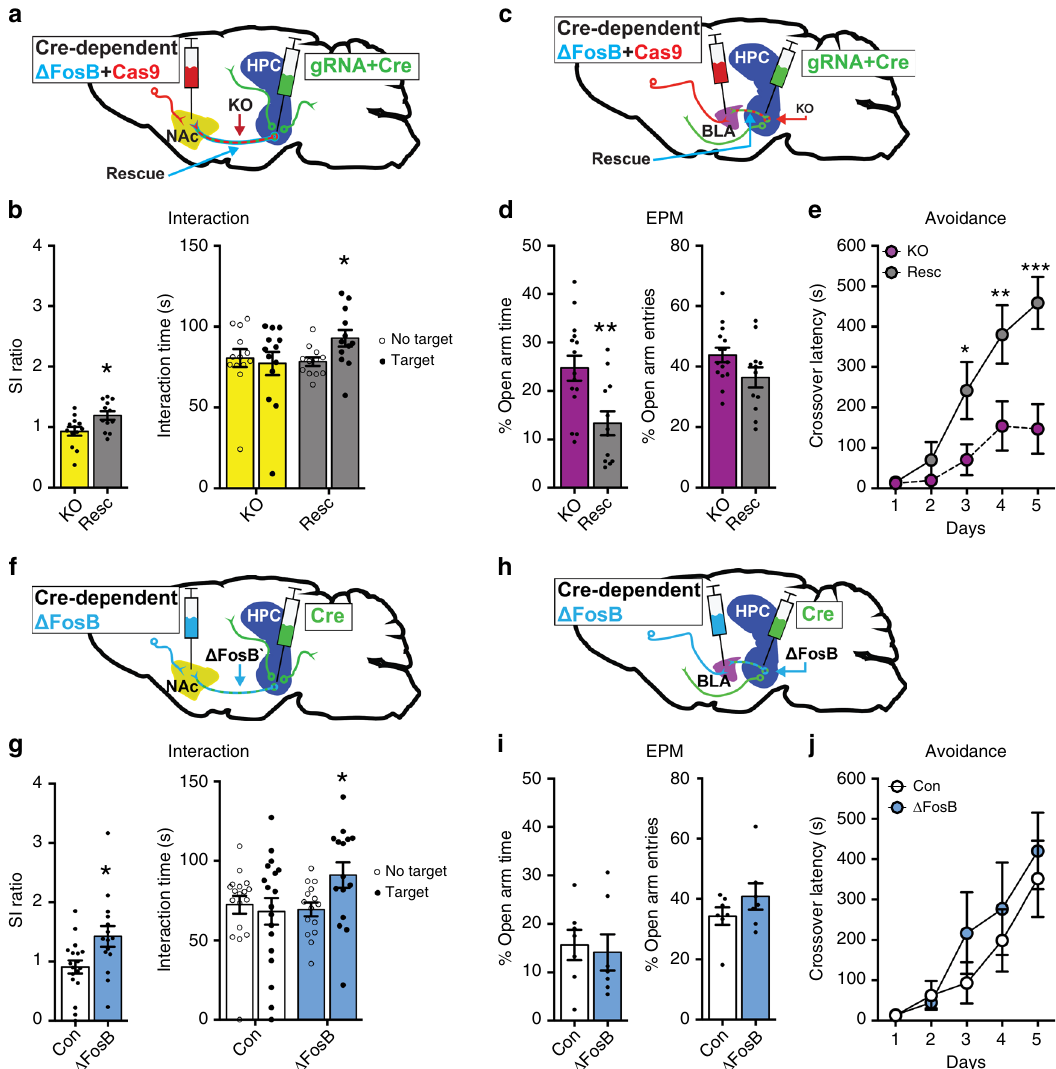
Fig. 3 Circuit-speci fi c vHPC Δ FosB mediates stress resilience and anxiety-like behavior. a Schematic of Δ FosB rescue experiments in vHPC-NAc afferent neurons. Retrograde vector expressing Cre-dependent Cas9 and Δ FosB is injected into NAc while local vector expressing Cre and FosB guide gRNA is injected into vHPC. FosB silencing (KO) occurs in co-transduced vHPC-NAc neurons, and Δ FosB overexpression is also driven by Cre in the same neurons (Rescue). b Δ FosB rescue (Resc) in vHPC-NAc neurons reverses stress-induced social avoidance, indicated by enhanced social interaction ratio (left) and increased investigation of a social target (right). * P = 0.0161 for SI ratio and * P = 0.0431 for interaction time ( n = 13 KO, n = 12 Resc; SI ratio: independent samples t -test compared to KO; investigation time: two-way mixed ANOVA with Holm – Sidak post-test KO No Target vs Target). c Schematic of Δ FosB rescue experiments in vHPC-BLA afferent neurons. d Δ FosB rescue in vHPC-BLA neurons reverses the anxiolytic effects of FosB silencing, decreasing open arm time in the EPM. ** P = 0.0042 ( n = 15 KO, n = 12 Resc; independent samples t -test compared to KO). e Δ FosB rescue also reverses avoidance learning impairment. * P = 0.0459, ** P = 0.0060, *** P < 0.0001 ( n = 15 KO, n = 13 Resc; two-way mixed ANOVA with Holm – Sidak post-tests compared to KO). f Schematic of Δ FosB overexpression in vHPC-NAc afferent neurons. Retrograde vector expressing Cre-dependent Δ FosB is injected into NAc while local vector expressing Cre is injected into vHPC. Δ FosB overexpression is driven by Cre only in co-transduced vHPC-NAc neurons ( Δ FosB). g Δ FosB overexpression in vHPC-NAc enhances social interaction following stress, producing a resilient phenotype. * P < 0.05 ( n = 18 control, n = 12 Δ FosB; SI ratio: independent samples t -test compared to control; interaction time: two-way ANOVA followed by Holm – Sidak post-test Δ FosB No Target vs Target). h Schematic of Δ FosB overexpression in vHPC-BLA afferent neurons. i , j Δ FosB overexpression in vHPC-BLA does not alter anxiety-like behavior or avoidance learning ( n = 7 mice/group). All graphs are represented as mean ± overexpress recombinant Δ FosB back into the same circuit in (Fig. 3b). Similarly, Δ FosB rescue in FosB KO vHPC-BLA neu- which we use CRISPR to silence FosB gene expression (Fig. 3a). rons (Fig. 3c) blocked the FosB KO-mediated reduction in basal These tools cause retrograde Cre-dependent Δ FosB and Cas9 anxiety (Fig. 3d) and impairment in avoidance learning (Fig. 3e). expression (Resc) or Cre-dependent Cas9 expression alone (KO). To control for the presence of CRISPR-Cas9-mediated FosB KO, Δ FosB was independently overexpressed in these same circuits by We injected these into NAc, and subsequently injected local HSV expressing Cre and the FosB gRNA into vHPC of adult mice injecting retrograde Cre-inducible Δ FosB in NAc or BLA (HSV- (Fig. 3a). Critically, Δ FosB rescue in FosB KO vHPC-NAc neu- hEF1 α -LSIL- Δ FosB) and persistent Cre (AAV2-CMV-Cre-GFP) rons reversed the enhancement in stress-induced social avoidance into vHPC (Fig. 3f, h), which produces Δ FosB overexpression